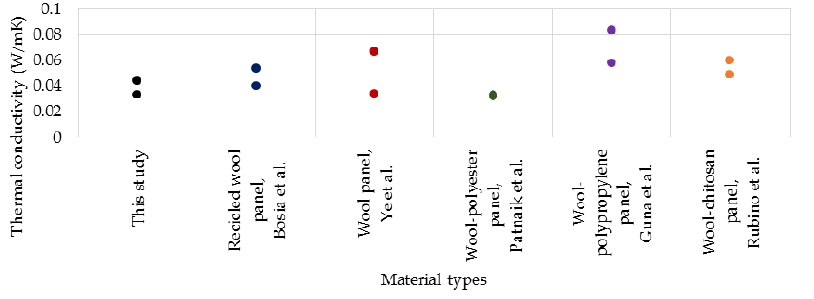
Figure 20. Thermal conductivity of samples; values of this study correspond to the minimum and maximum values recorded (data from Refs. [17,19,20,40,50]).